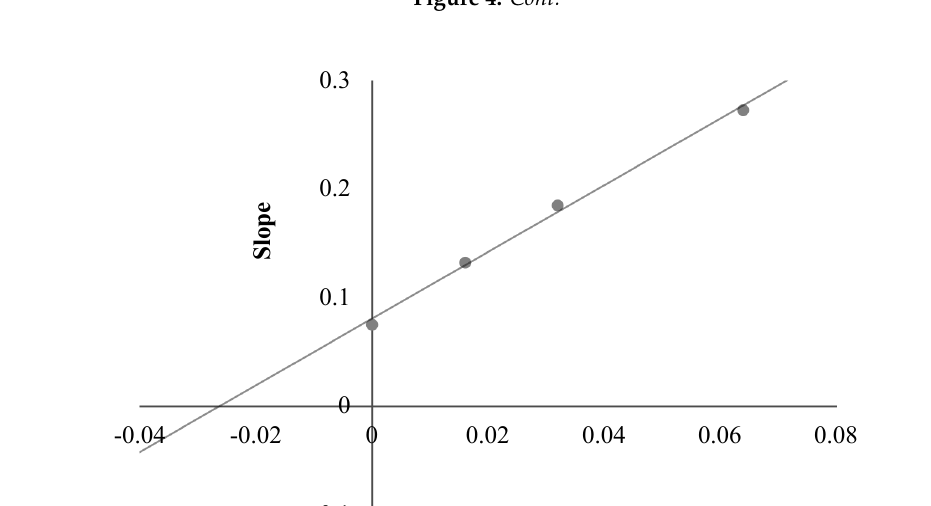
Molecules 2019 , 22 , x FOR PEER REVIEW